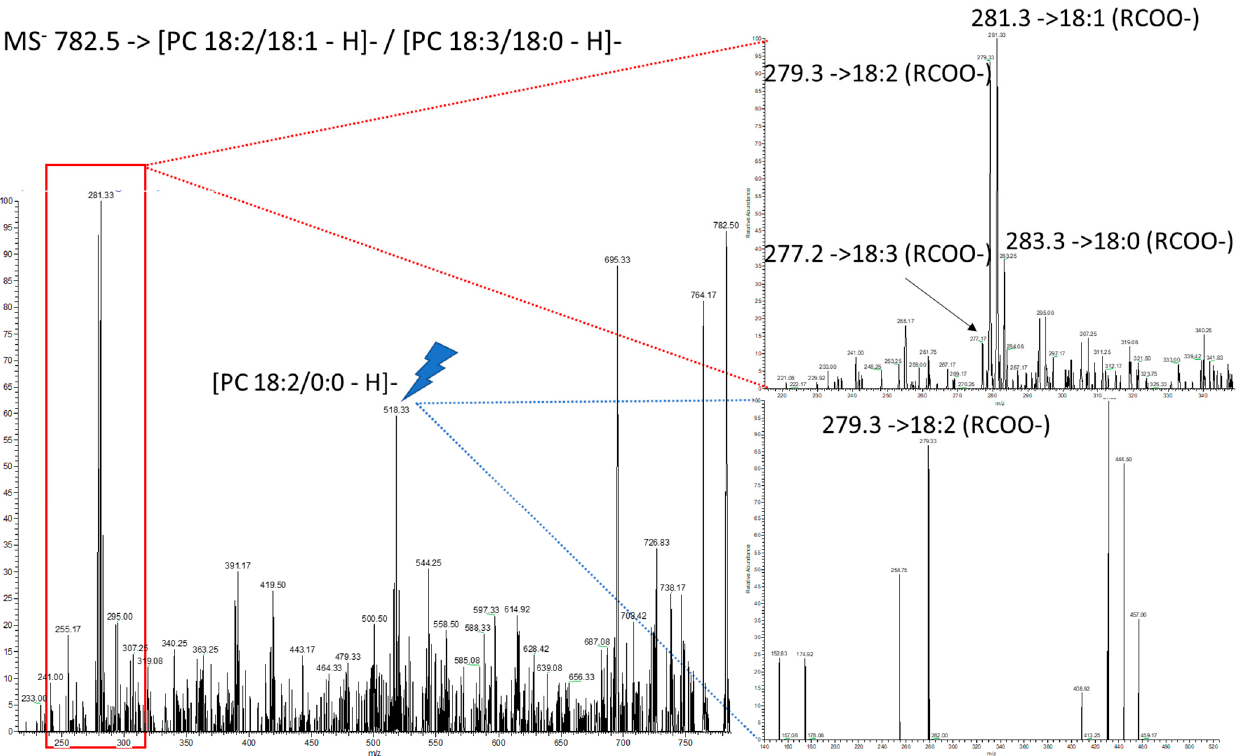
Figure A2. MS/MS and MS 3 analysis of the extract of the mixture of the three different types of milk with MALDI on the m/z corresponding to the adduct [PC 36:3 -H]- (782.5).